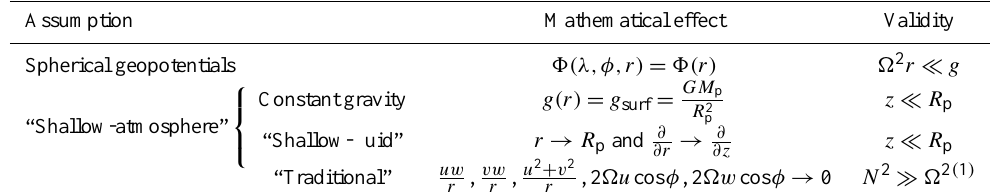
Table 1. Table showing approximations made to the equations of motion (or associated geometry), the actual effect on the terms of Eq. (1) and the validity criteria. Here R p is the radius of the planet, z is the distance from the surface of the planet, i.e. r = z + R p , M p is the mass of the planet, in this case Earth, and N is the buoyancy (or Brunt–Väisälä) frequency. (1) This validity criterion is from Phillips (1968), however, the validity of the “traditional” approximation is debatable and may break down for planetary-scale flows (see White and Bromley, 1995, for a